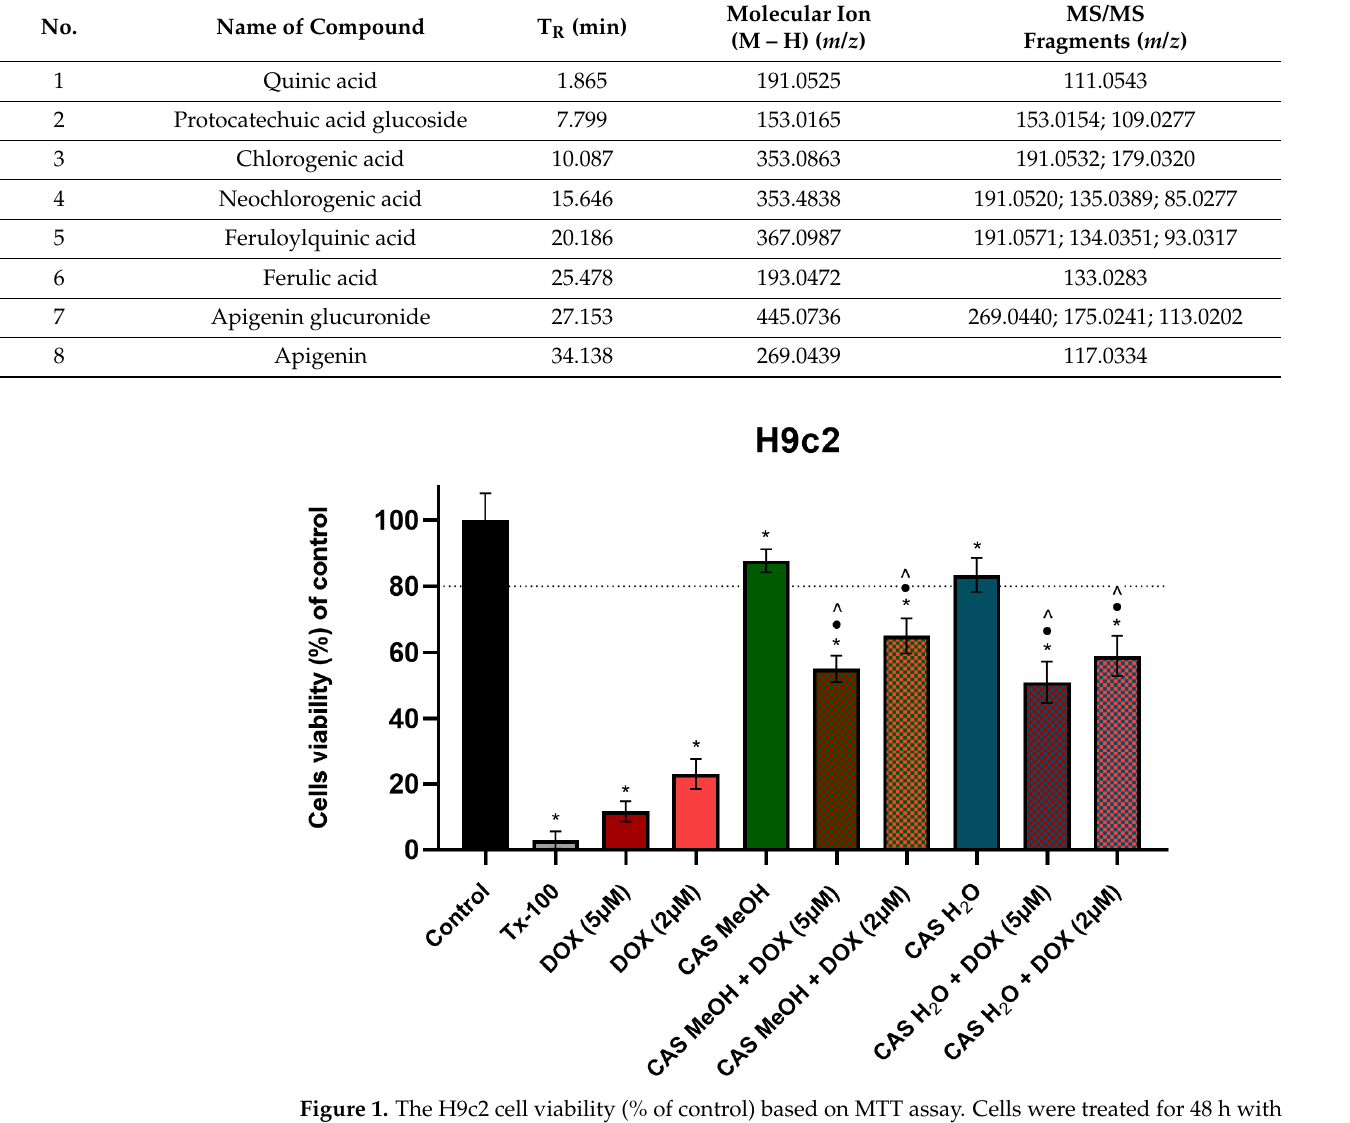
Figure 1. The H9c2 cell viability (% of control) based on MTT assay. Cells were treated for 48 h